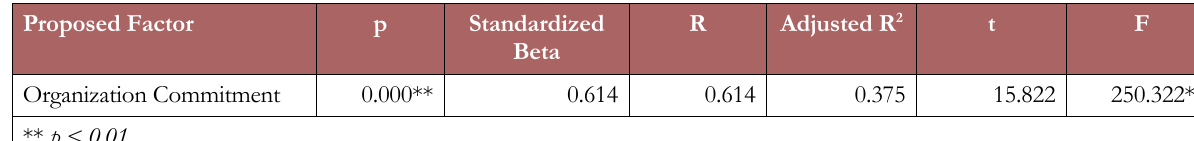
Table 3. Regression Analysis of OC on Employee Retention [n = 416]